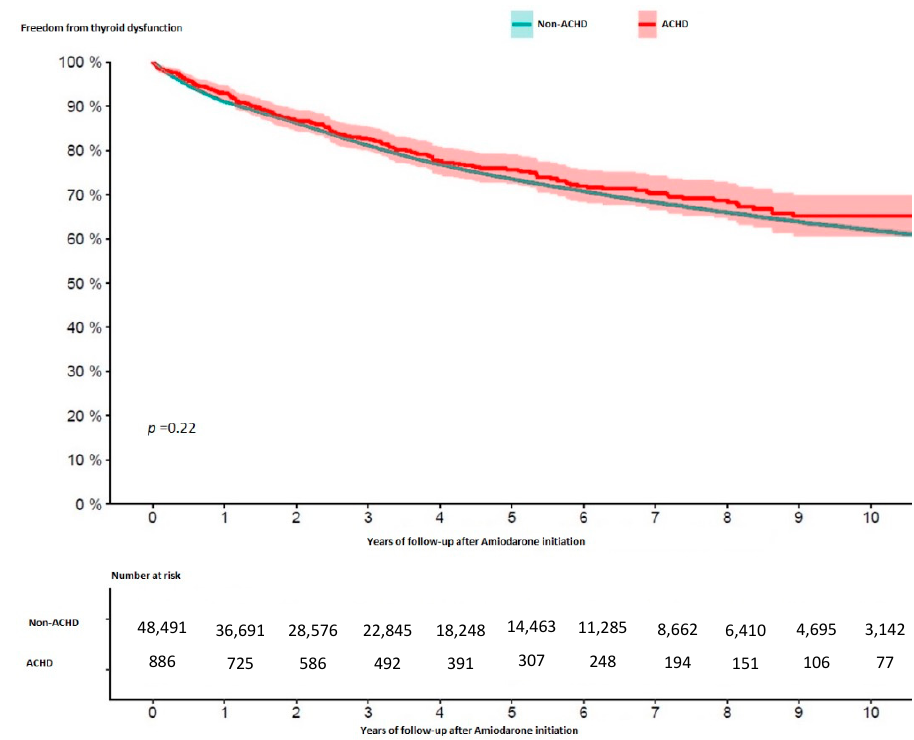
Figure 1. Kaplan–Meier estimates of the occurrence of thyroid dysfunction stratified between adults with congenital heart disease (ACHD) and without congenital heart disease. Irrespective of diagnosis of congenital heart disease, hypothyroidism was documented more frequently (14.5% non-ACHD versus 15.6% ACHD patients; p = 0.36) than hyperthyroidism (10.4% non-ACHD versus 11.6% ACHD patients; p = 0.24) in both cohorts.